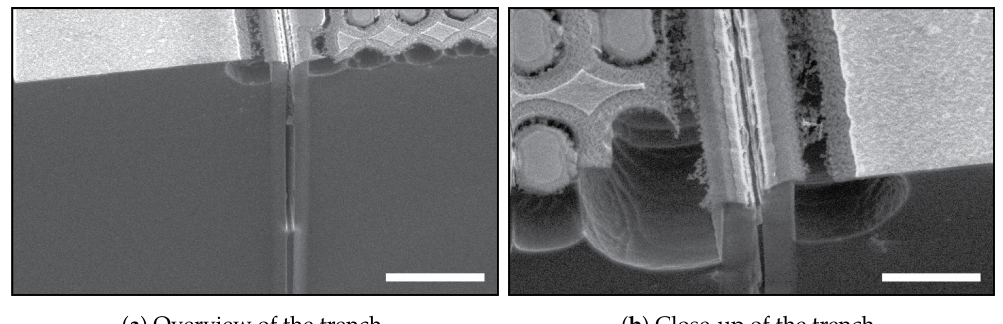
Figure 1. SEM images showing a failed channel etch in the TASCT process [11]. In ( a ), an overview, and in ( b ), a close-up of unwanted etching of the silicon surface in an SF 6 -based RIE step caused by a non-uniform photo-resist layer in the neighbourhood of a trench structure with an opened keyhole. The scale bar in ( a ) is 10µm and in ( b ) is 5µm.